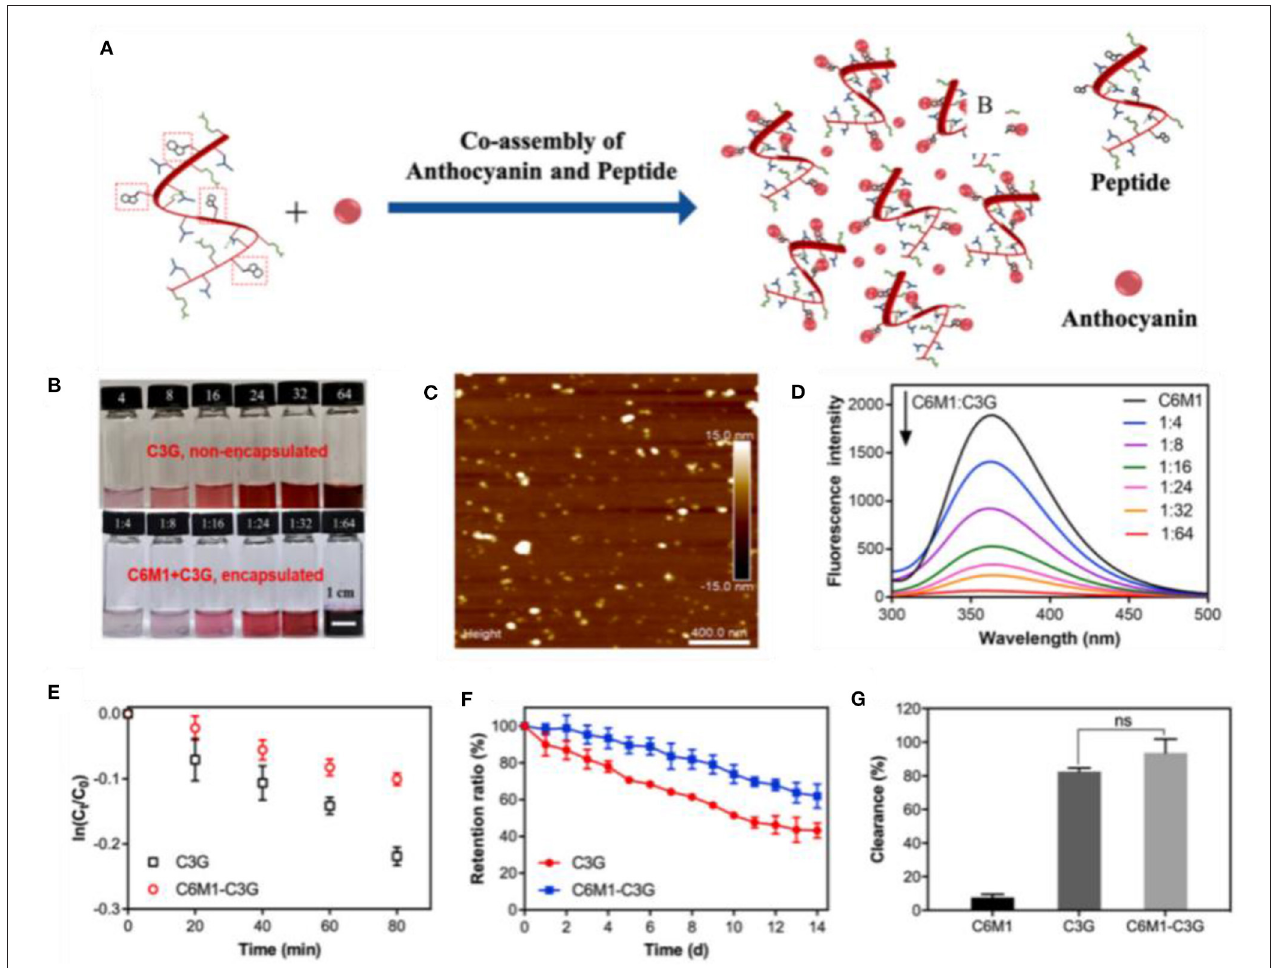
FIGURE 4 | (A) Schematic of the co-assembly of the peptide (C6M1) and anthocyanin (C3G) into a nanocomposite. (B) Encapsulated and non-encapsulated anthocyanins. (C) Atomic force microscopy image and (D) fluorescence spectra of C6M1–C3G nanocomposites. (E) Thermal stability (80 ◦ C), (F) retention ratio during storage (25 ◦ C), and (G) activity tests of C3G and C6M1–C3G. Reproduced from reference ( 52) with permission.